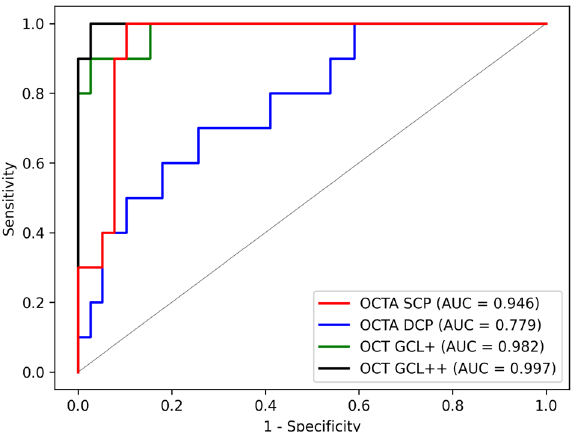
Figure 1. Receiver operating characteristic (ROC) curves of deep learning (DL) models for distinguishing highly myopic glaucoma from healthy high myopia. AUC, area under the receiver operating characteristic curve; DCP, deep capillary plexus; GCL+, ganglion cell layer + inner plexiform layer; GCL++, retinal nerve fiber layer + ganglion cell layer + inner plexiform layer; SCP, superficial capillary